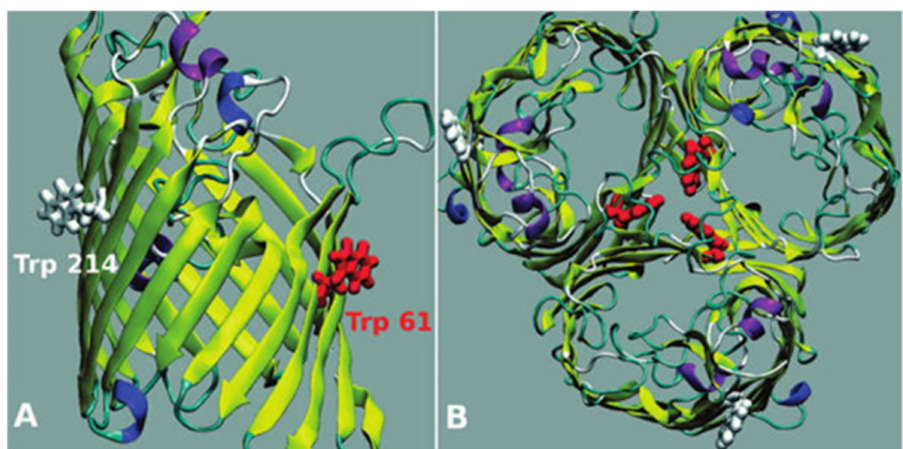
Figure 5. OmpF porin: a monomer side view ( A ) and the homotrimer top view ( B ). The two Trp residues of the monomers of the porin are represented in red (W61) and in white (W 214). Reprinted (adapted) with permission from Journal of the American Chemical Society, 130, Mach, T., Neves, P., Spiga, E., Weingart, H., Winterhalter, M., Ruggerone, P., Ceccarelli, M. and Gameiro, P., Facilitated Permeation of Antibiotics across Membrane Channels—Interaction of the Quinolone Moxifloxacin with the OmpF Channel, 13301-13309. Copyright 2008 American Chemical